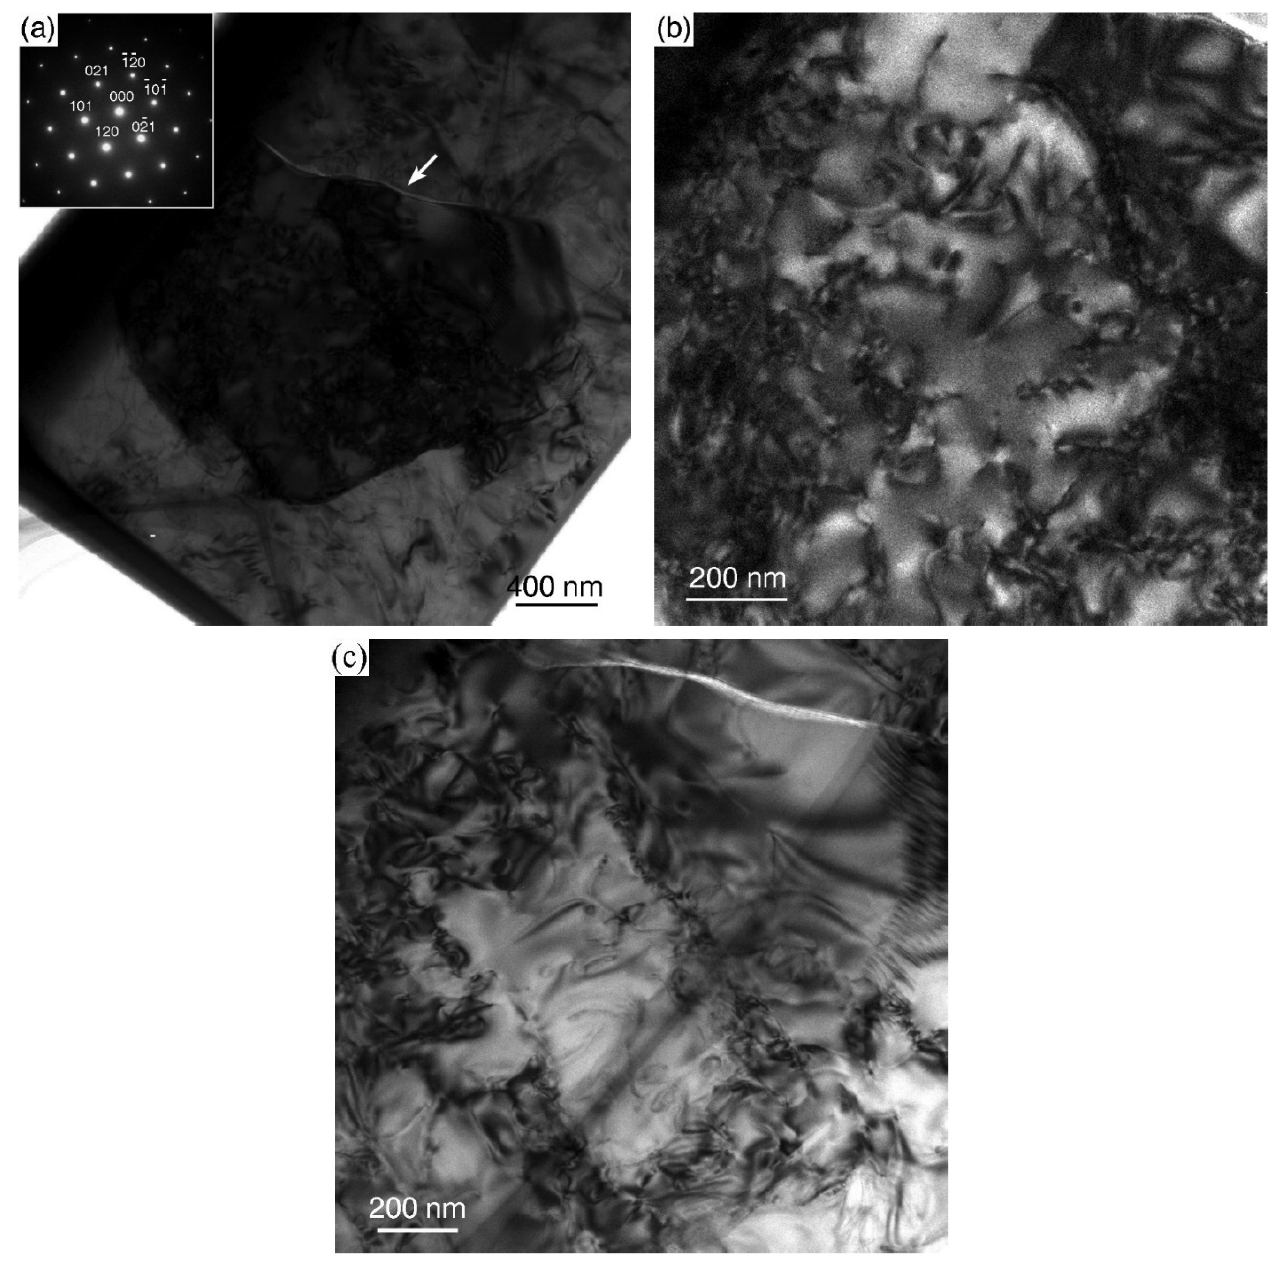
Figure 6. BF images with [-2-12] incidence. ( a ) A small olivine grain with approximately 2 µ m inside a larger grain. The white arrow indicates a micro-crack between the two. ( b ) Tangles of dislocations in this grain. ( c ) A dislocation cell substructure surrounded by tangles of